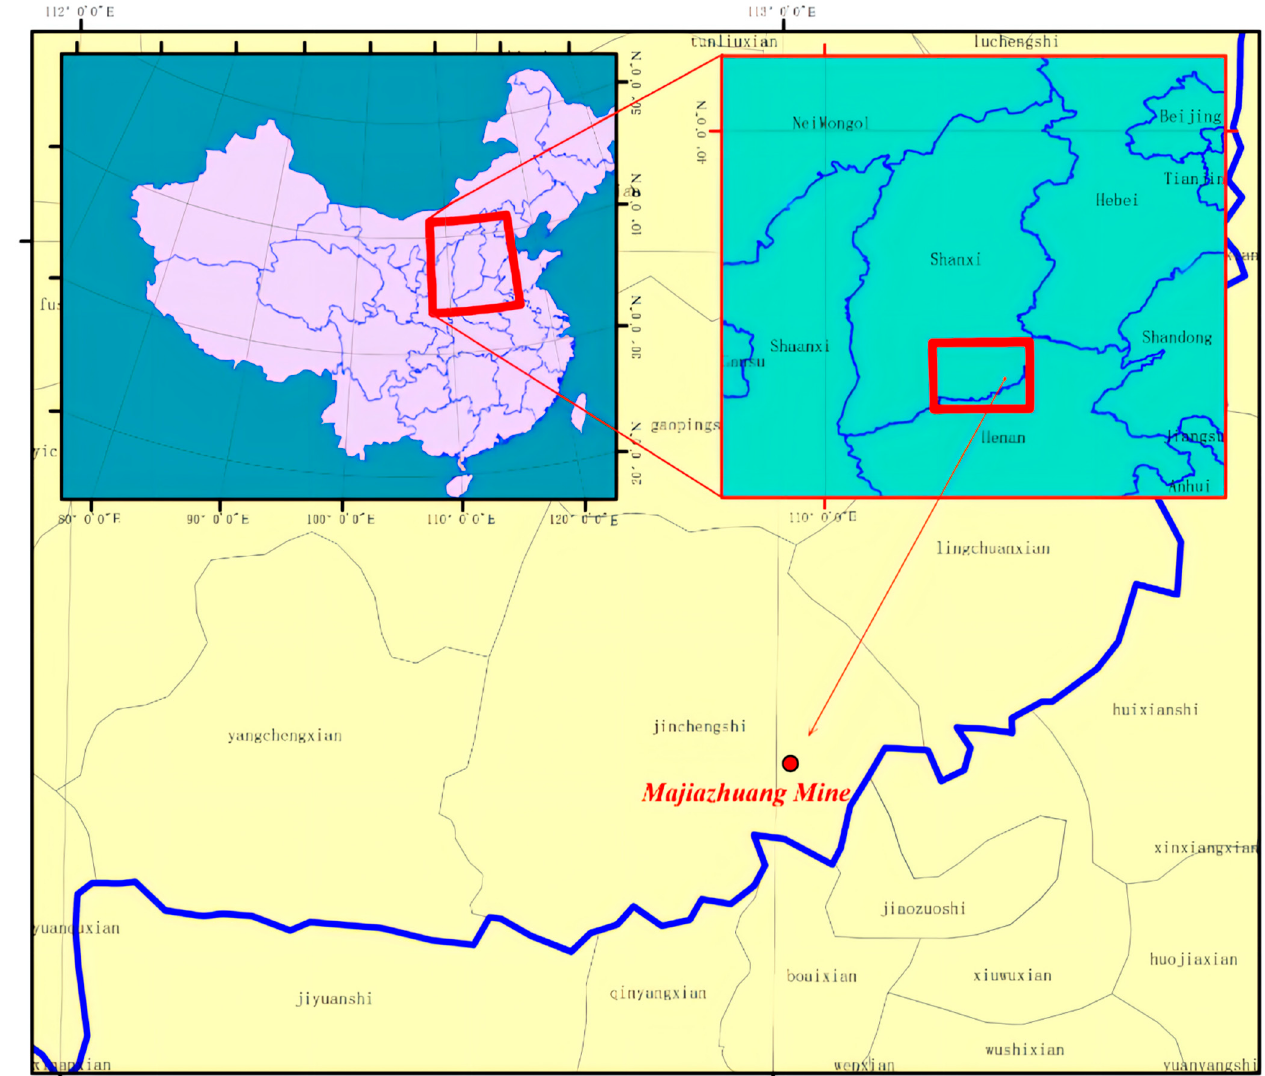
Figure 2. Geographical location of the study area.